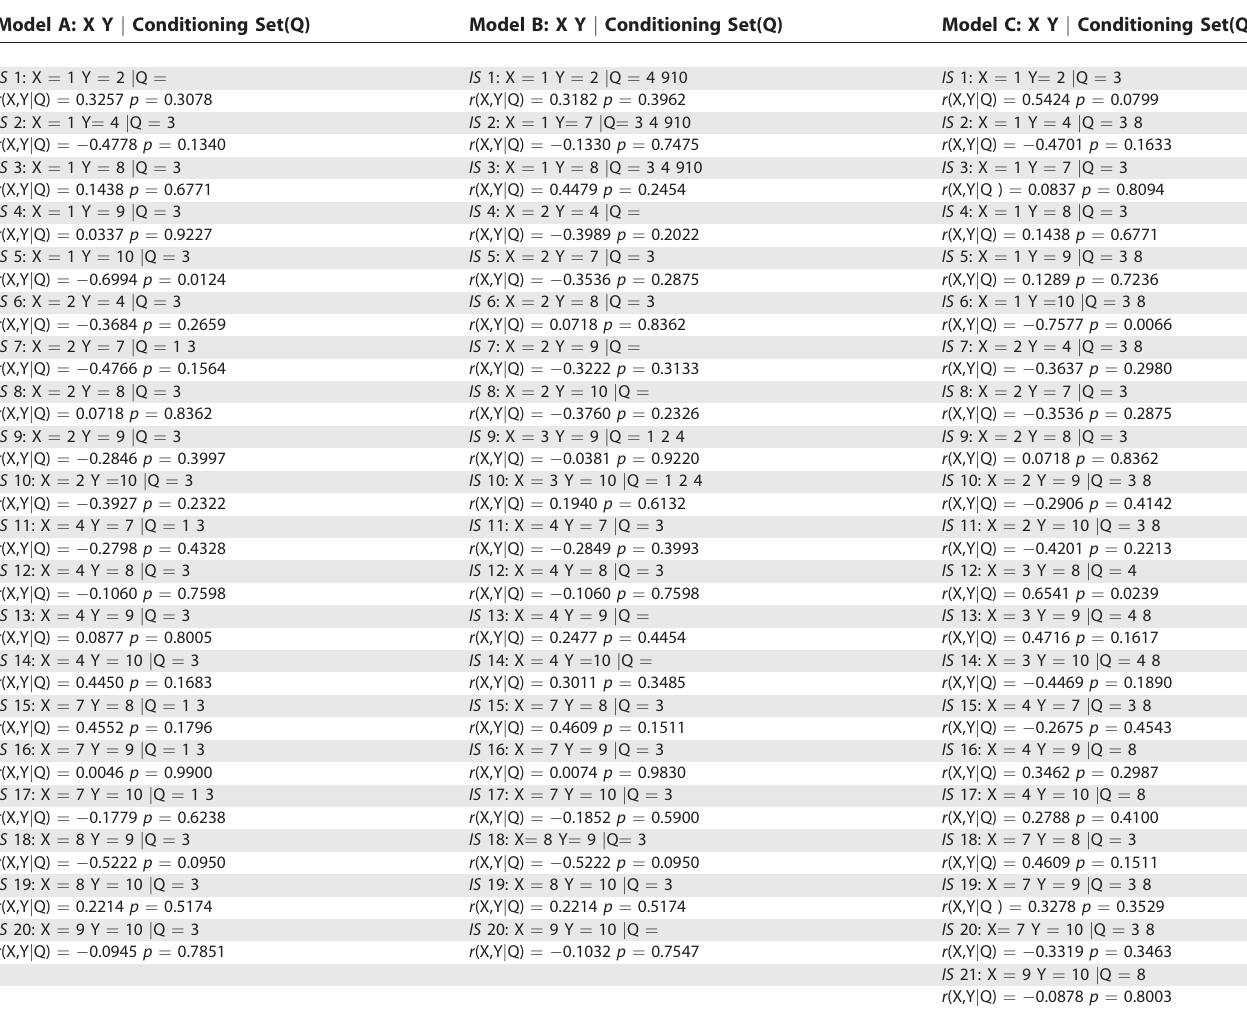
Table 1. D-Separation Claims and Associated Partial Correlation Coefficients and Corresponding Probability Values Model A: X Y j Conditioning Set(Q) Model B: X Y j Conditioning Set(Q) Model C: X Y j Conditioning